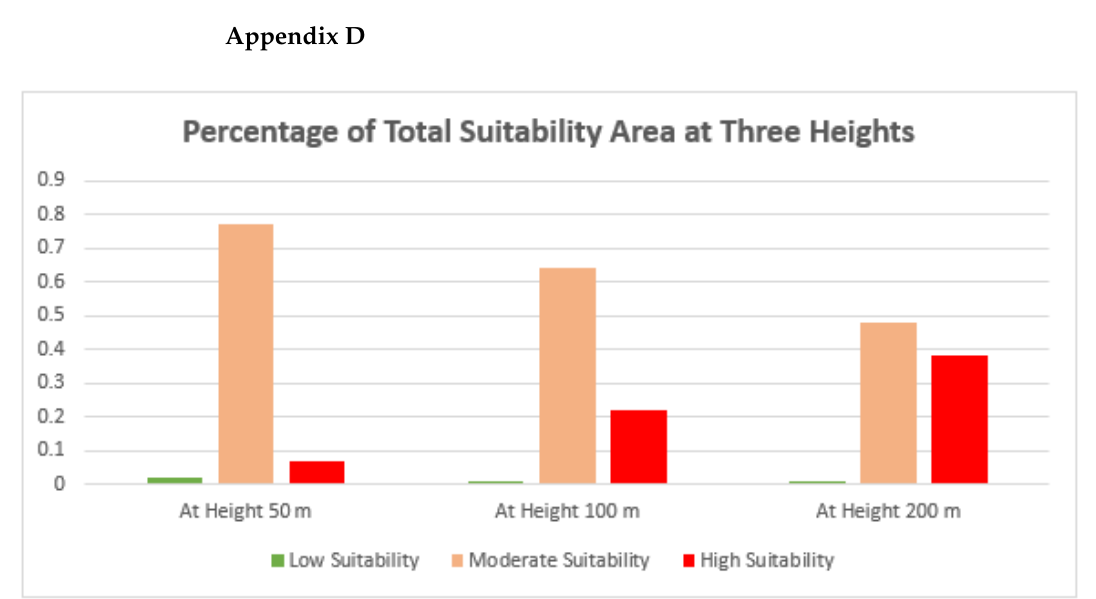
Figure A2. Land Area Percentage of Total Suitability Area at the Three Heights in Jordan.